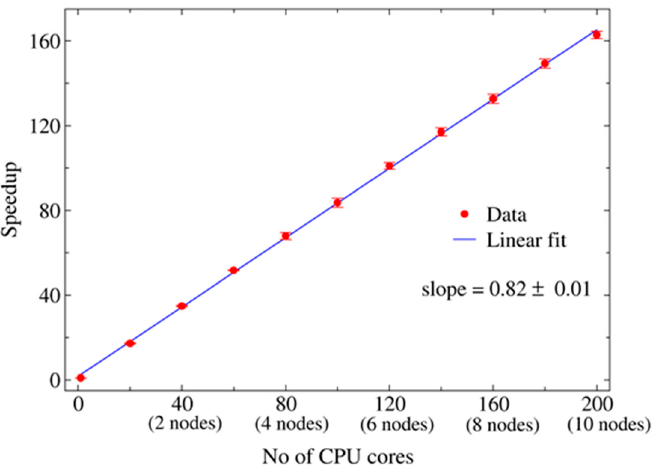
Figure 2. Speedup of the Restricted Boltzmann Machine (RBM) code as a function of the number of CPU cores used. The speedup was measured over 10,000 iterations of the PCD algorithm (k = 10), with a mini-batch size of 25,000.